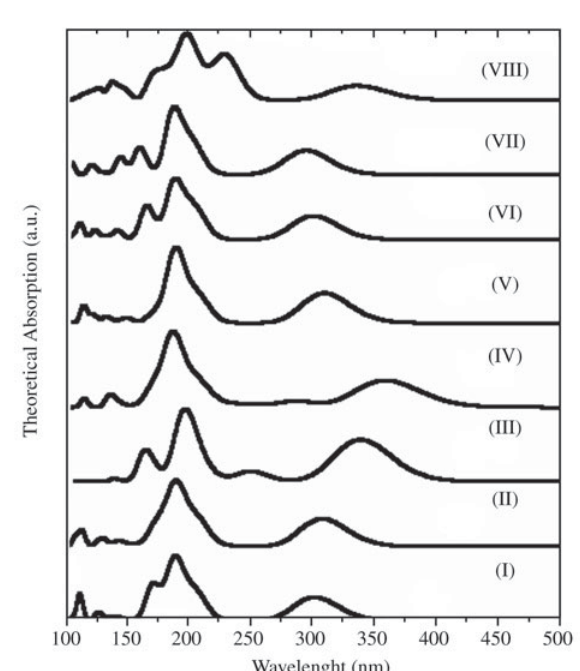
Figure 3 . Theoretical UV-vis absorption spectra of alkynes I-VIII (Table 1) calculated for optimized geometries by INDO/S-CI by PM3